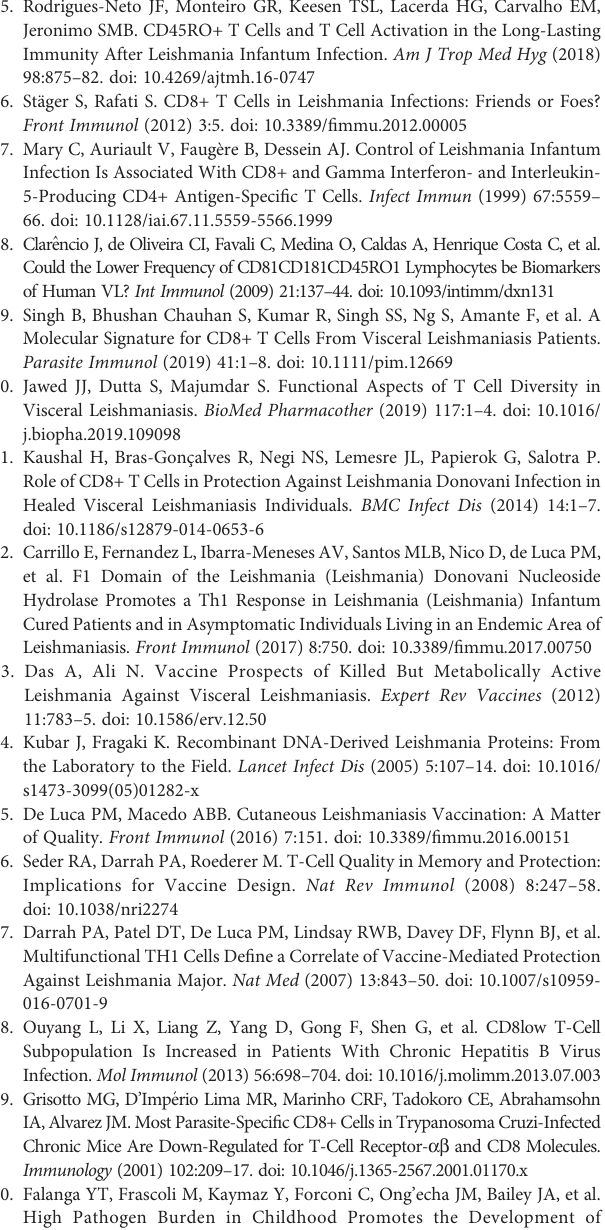
Supplementary Figure 2 | Evolution of the relative proportions of each CD4 + cytokine-expressing subtype along the time of treatment. The graph represents the variation of the percent of each type of T cell among all cytokine-expressing CD4 + T cells along the time.